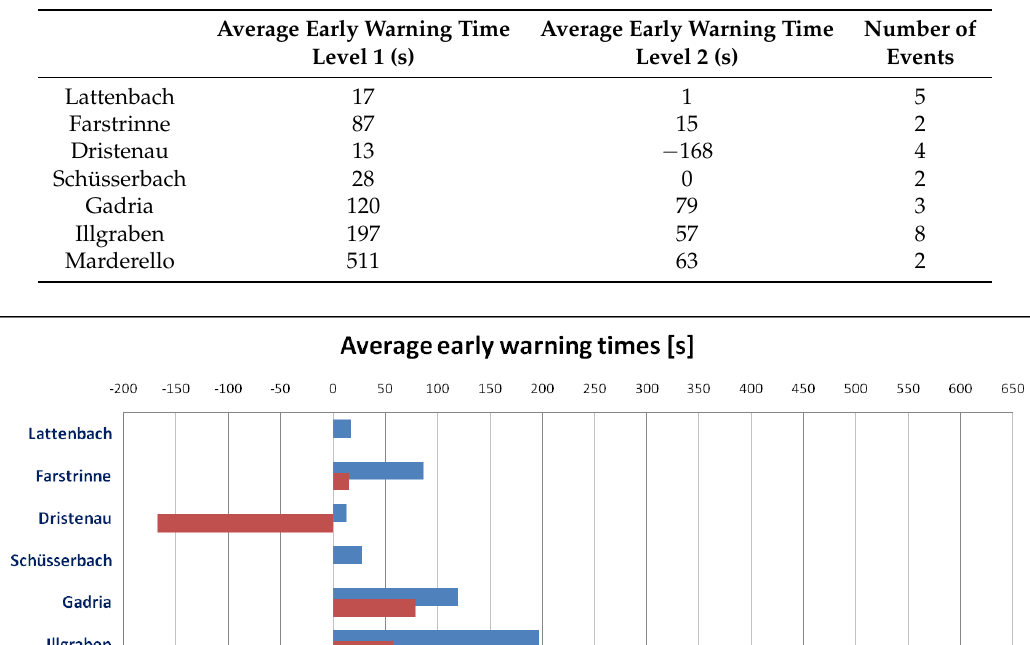
Table 4. Average early warning times for Level 2 debris flow/debris flood at different test sites.